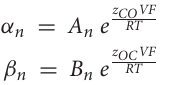
60, and 100mV from a holding potential of 80mV are shown. + + − 175nM). Voltage-clamp steps = 5, = Ca , with different −